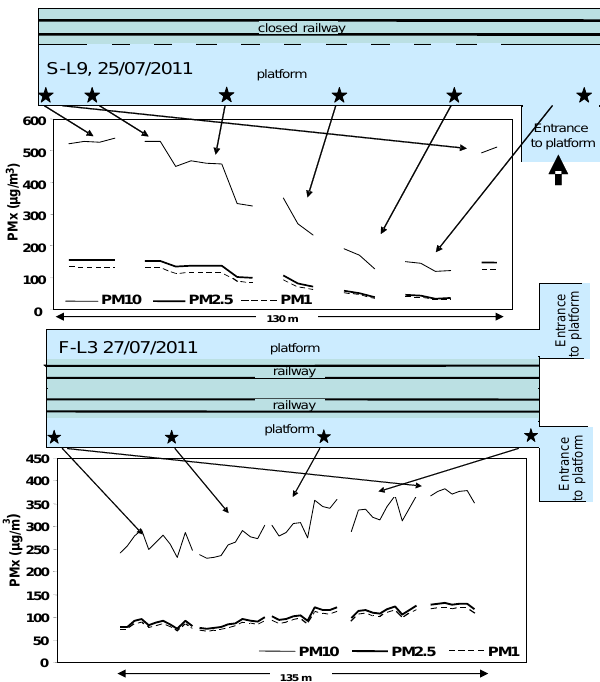
Fig. 2. Five minute PM 10 , PM 2 . 5 and PM 1 levels measured along the platforms at the Sagrera (S-L9) and Fontana (F-L3) stations.